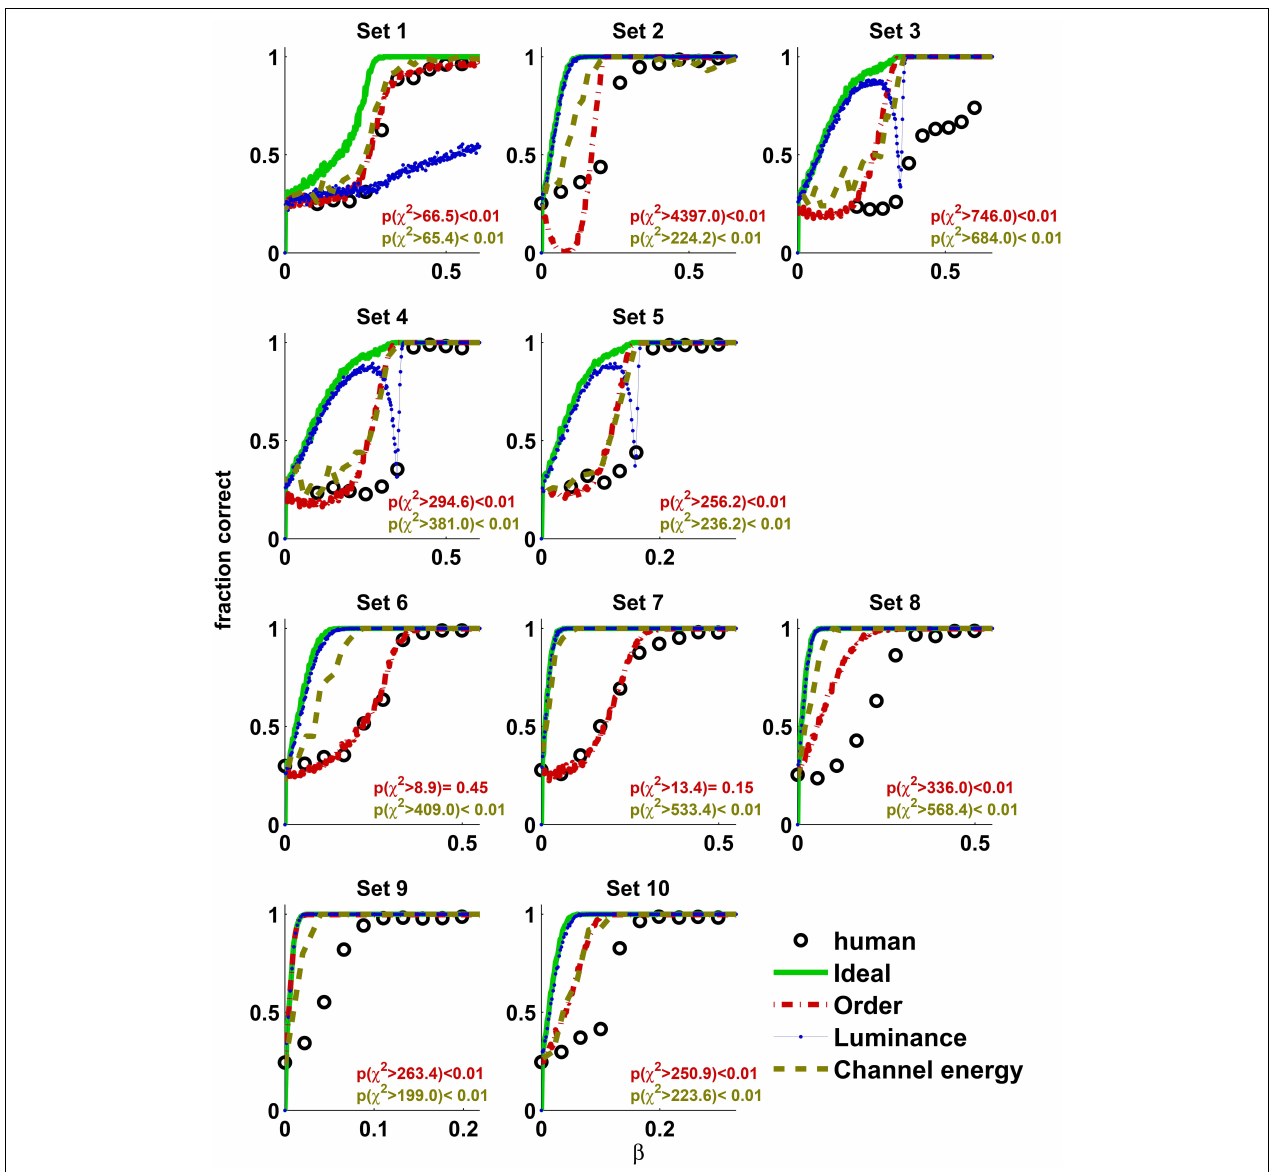
The performance of the Order observer was much closer to that of the human observers. In 3 cases (Texture sets 1, 6, and 7) there is a close match between the human and the Order observers’ performances. χ 2 statistics for Order (top) and Channel energy (bottom) observers are presented in the inset. In all cases there are 9 degrees of